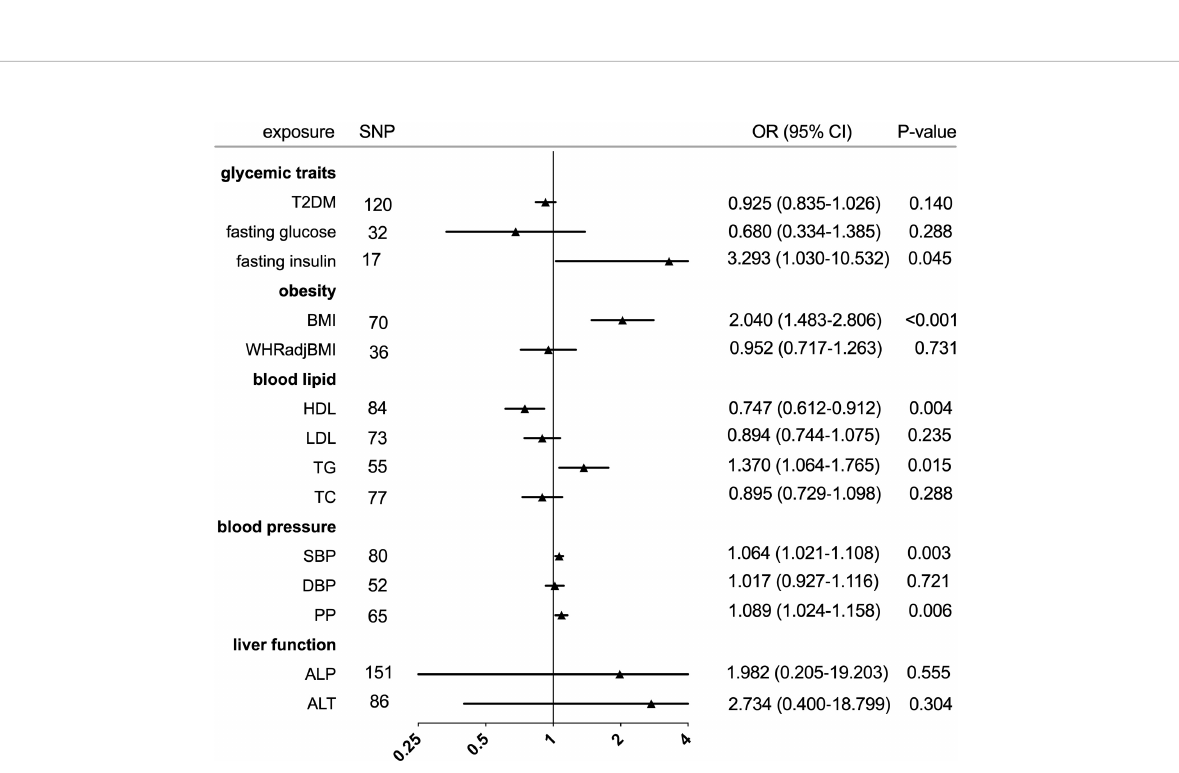
FIGURE 2 Forest plot of Mendelian randomization analyses for the genetical associations of glycemic traits, obesity, blood lipid, blood pressure, and liver function with risk of gout. CI, con fi dence interval; SNP, single-nucleotide polymorphism; OR, odds